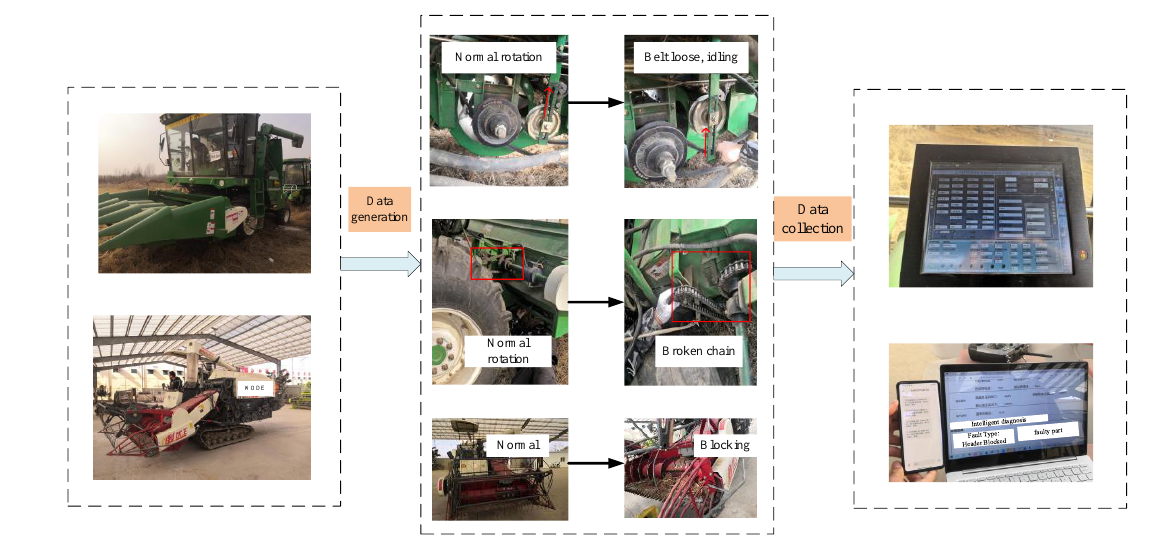
Figure 9. Fault diagnosis and monitoring test of combine harvester.